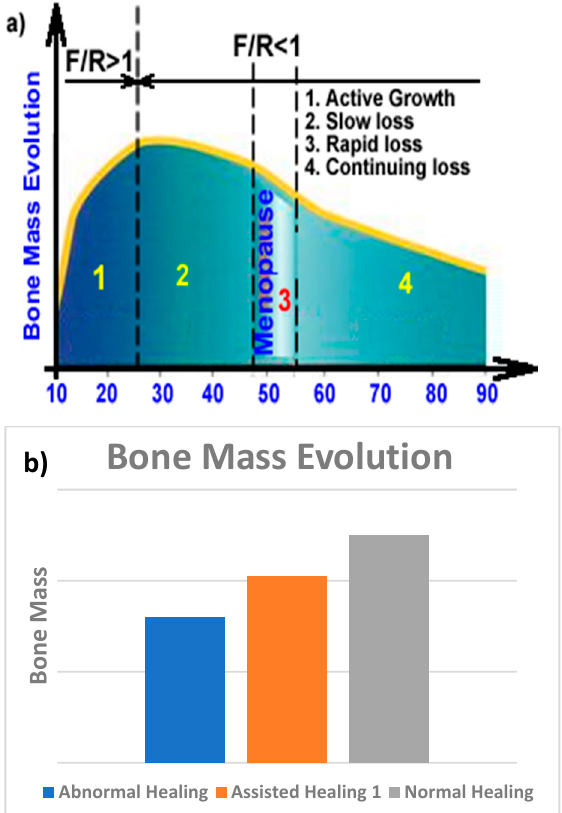
Figure 7. ( a ) Bone mass evolution during life; ( b ) bone mass evolution in normal versus assisted healing of bone defects.